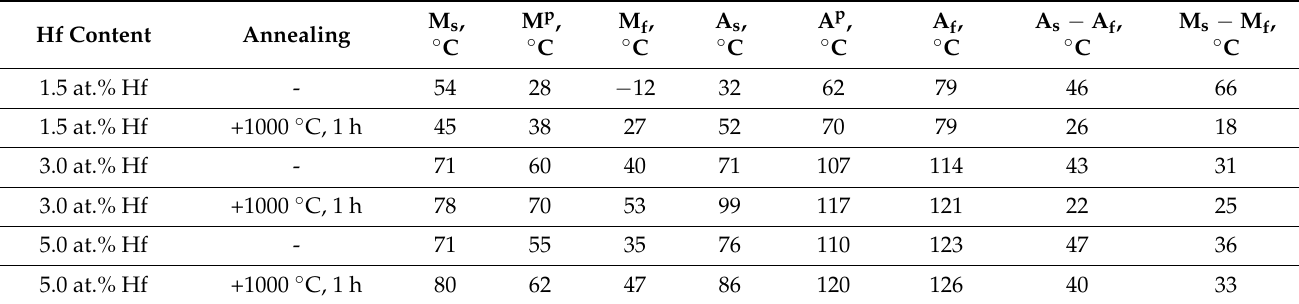
Table 4. Characteristic temperatures of forward and reverse MTs of TiNiHf initial ingots in as-cast state and after annealing at 1000 ◦ C for 1 h.